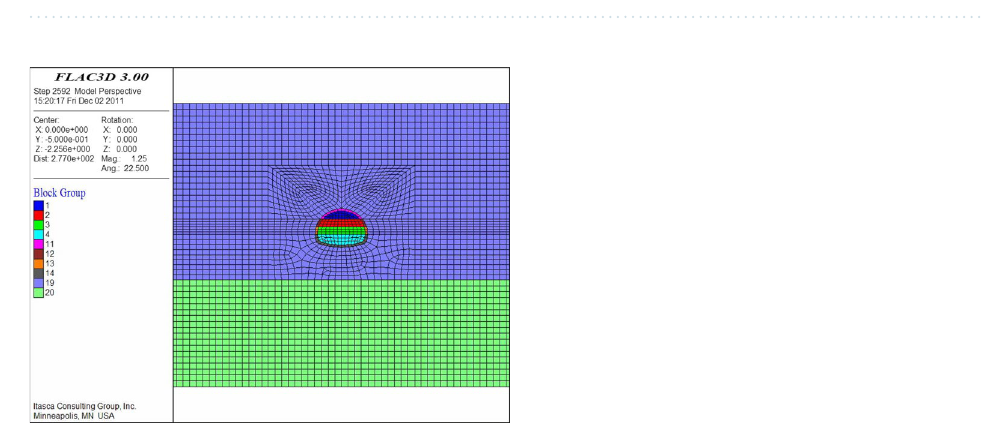
Figure 11. CRD method (FLAC3D 3.0 http:// docs. itasc acg. com/ flac3 d700/ flac3d/ docpr oject/ source/ flac3 dhome. html).